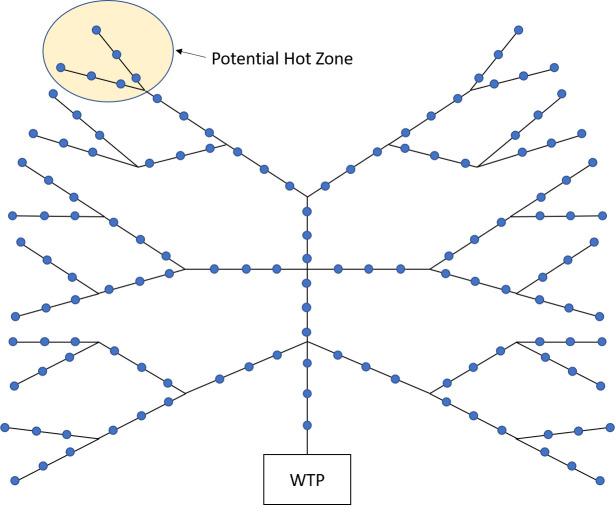
A stylized network.